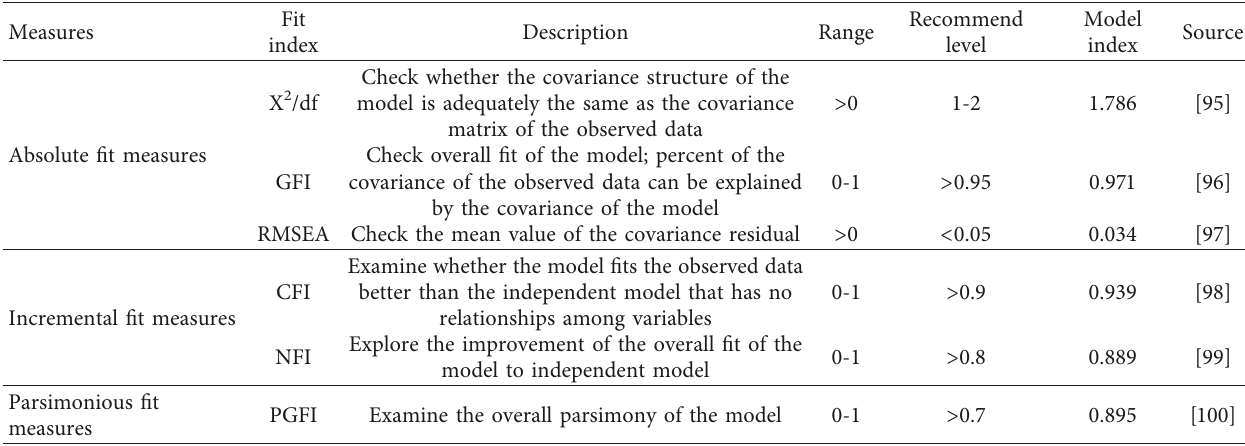
Table 4: Model fit indices of the proposed model.